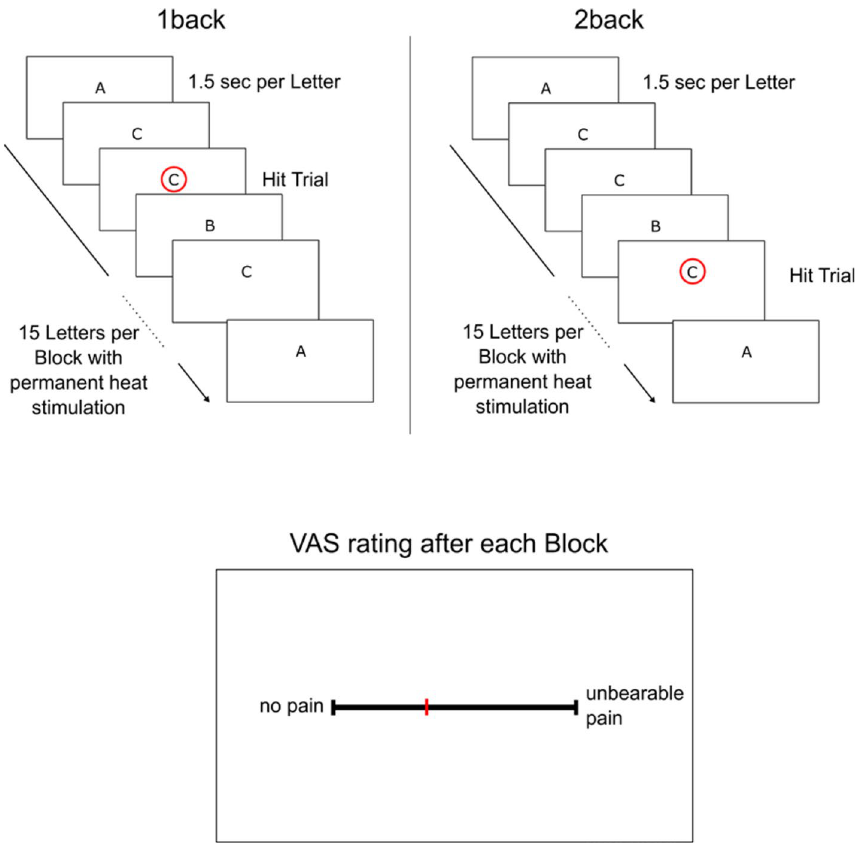
Figure 5. Working Memory Paradigm “n-back”. The upper left part illustrates the easier version of the working memory paradigm (“1-back”). The participant watched a stream of letters and had to respond when the same letter is presented two times in a row, as indicated by the red circle. The upper right part illustrates the more difficult version of the working memory paradigm (“2-back”). The participant watched a stream of letters and had to respond when the letter was the same as the one before the last letter, as indicated by the red circle. While the participant was involved in the task, a heat pain was applied on the forearm, and the participants rated their heat pain experience after each block on a visual analogue